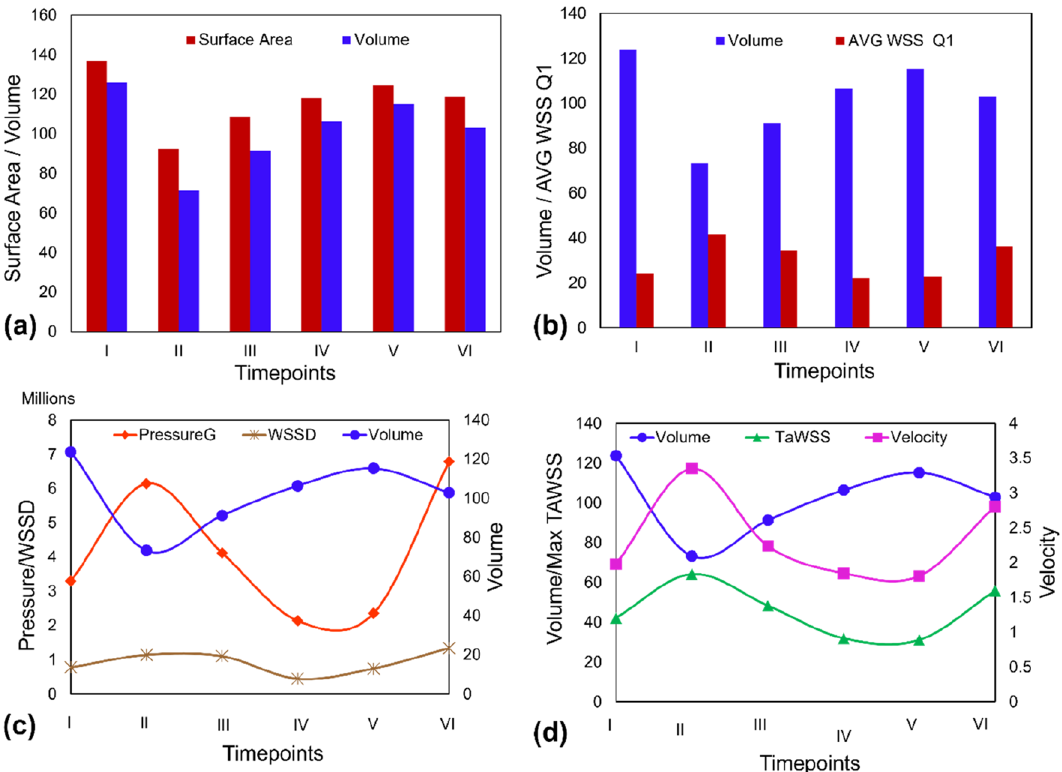
Figure 9. Morphology and hemodynamic comparisons of the aneurysm models reconstructed by operator D ( a ) Variation of surface area and volume for the aneurysm at different timepoints; ( b ) Correlation between volume and the average value of the first quartile of the WSS area; ( c ) Correlation between aneurysm volume, pressure gradient and wall shear stress divergence; ( d ) Correlation between aneurysm volume and maximum values of TaWSS and